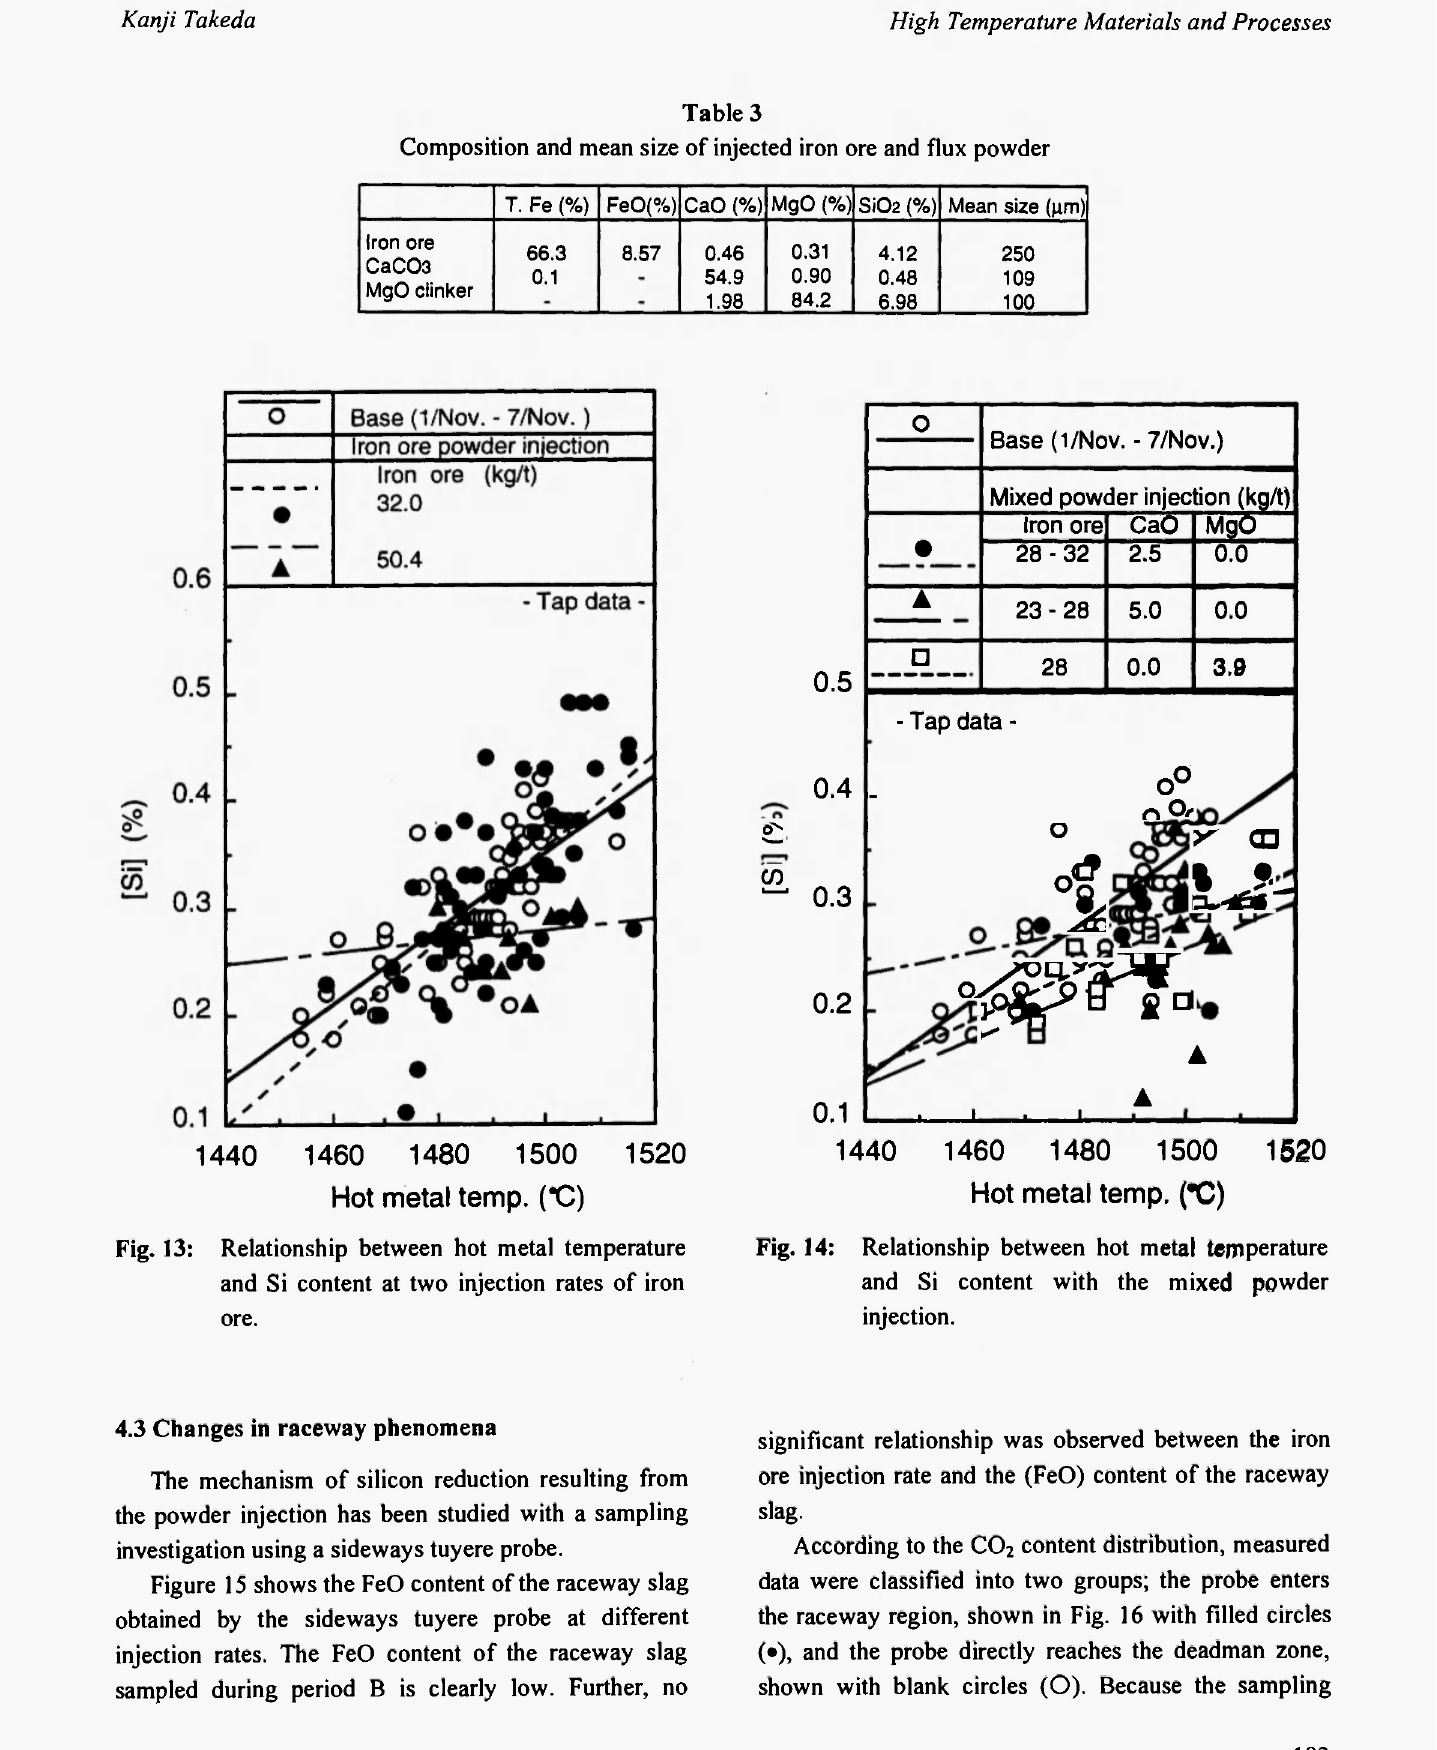
Fig. 13: Relationship between hot metal temperature and Si content at two injection rates of iron ore.